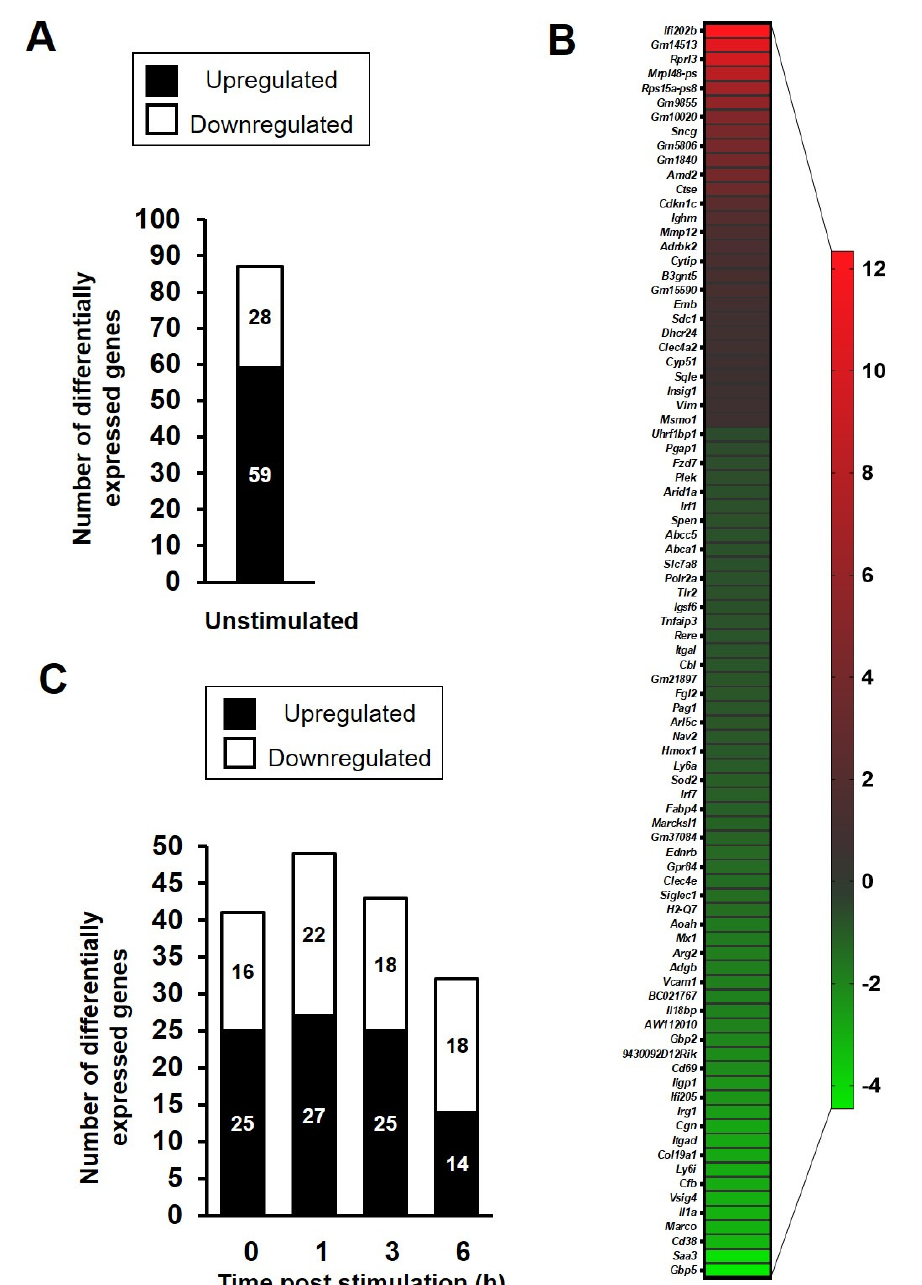
Figure 2. Gene expression changes in p65 ‐ DsRedxp/I κ B α‐ eGFP bone marrow ‐ derived macrophages (BMDMs) as identified by RNA sequencing. BMDMs were left unstimulated or stimulated with 100 ng/mL Lipid A for 1, 3, and 6 h ( n = 3 mice per treatment group). Total RNA was isolated, RNA sequencing was performed, followed by informatics analysis. ( A ) Total number and ( B ) heatmap of 87 differentially expressed (DE) genes (upregulated [red], downregulated [green]) in unstimulated p65 ‐ DsRed/I κ B α‐ eGFP BMDMs relative to wild ‐ type C57BL/6J mice, having an adjusted p ‐ value of < 0.05, corrected for multiple testing using the Benjamini and Hochberg method. ( C ) Number of differentially expressed genes, using a cut ‐ off log2 fold changes ≥ 1.5 and ≤ − 1.5, in unstimulated and Lipid A ‐ stimulated p65 ‐ DsRedxp/I κ B α‐ eGFP BMDMs (100 ng/mL lipid A, at 1, 3 and 6 h); n = 101 genes across all treatment groups.